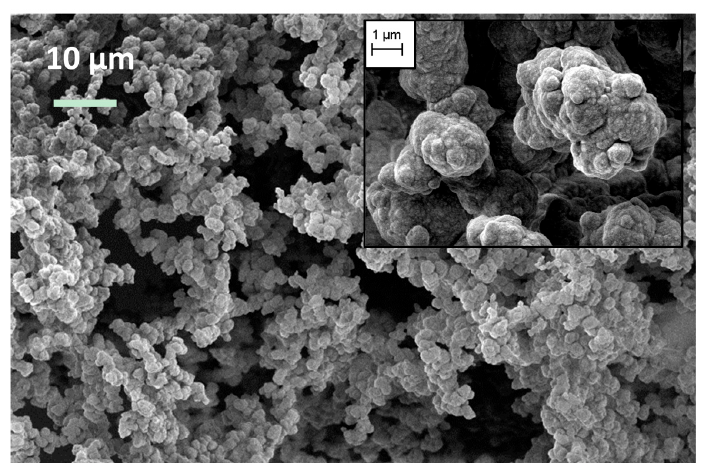
Figure 2. Microstructure of SA1 (magnification of image 1k× and of inset 5k×).